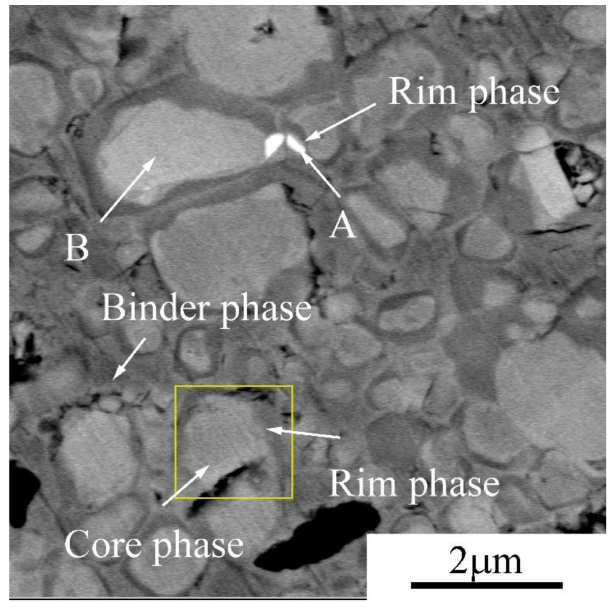
Figure 5. SEM image of the cermet C